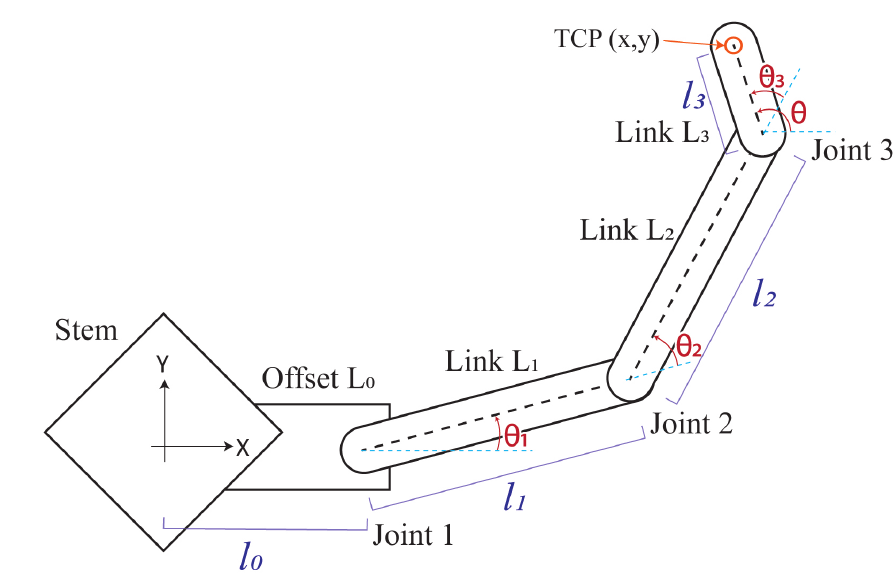
Figure 4. Kinematic parameters of the robot